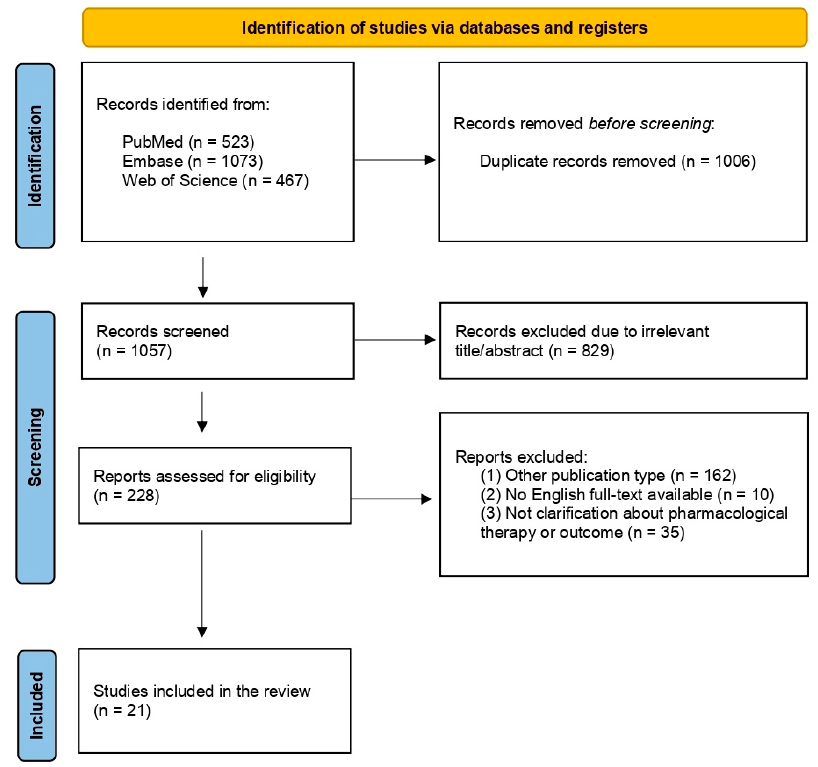
Figure 1. PRISMA flow diagram of the study selection process. PRISMA, Preferred Reporting Items for Systematic reviews and Meta ‐ Analyses.